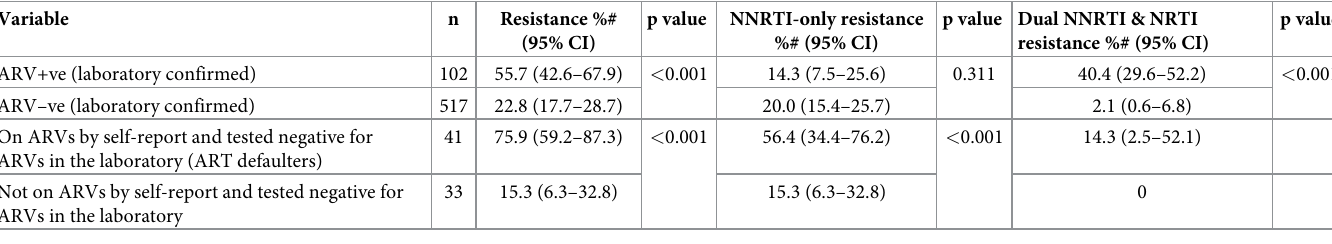
Table 3. HIV drug resistance by ARV status, South Africa,